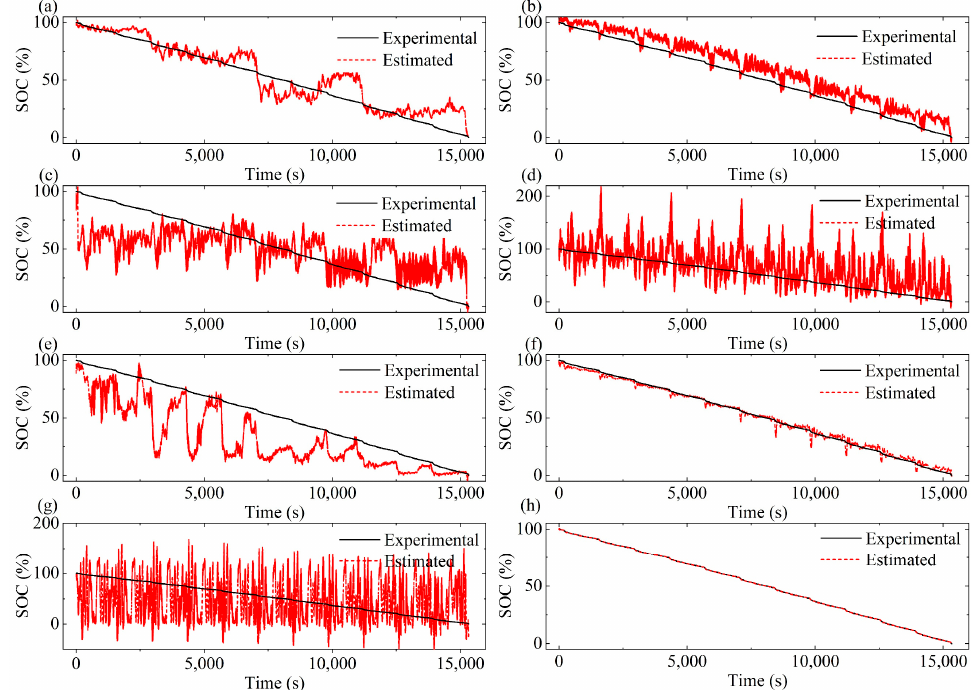
Figure 6. The SOC estimation results of the TCN model with different input parameters based on the ICR18650 battery (works at the FUDS condition under 25 °C): ( a ) current, voltage, and temperature; ( b ) voltage and temperature; ( c ) current and temperature; ( d ) current and voltage; ( e ) temperature; ( f ) voltage; ( g ) current; ( h ) observed SOC calculated by the optimized state function.